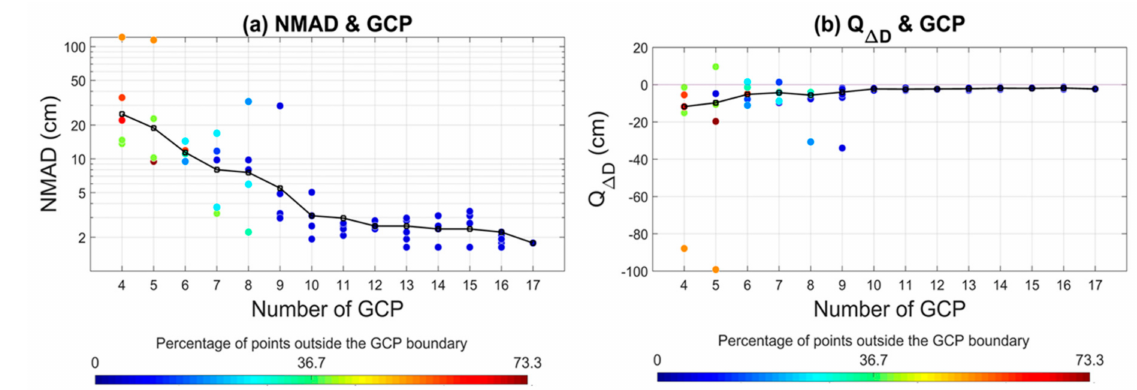
Figure 10. ( a ) NMAD and ( b ) Median of the estimated snow depth varying with the number of GCPs used for